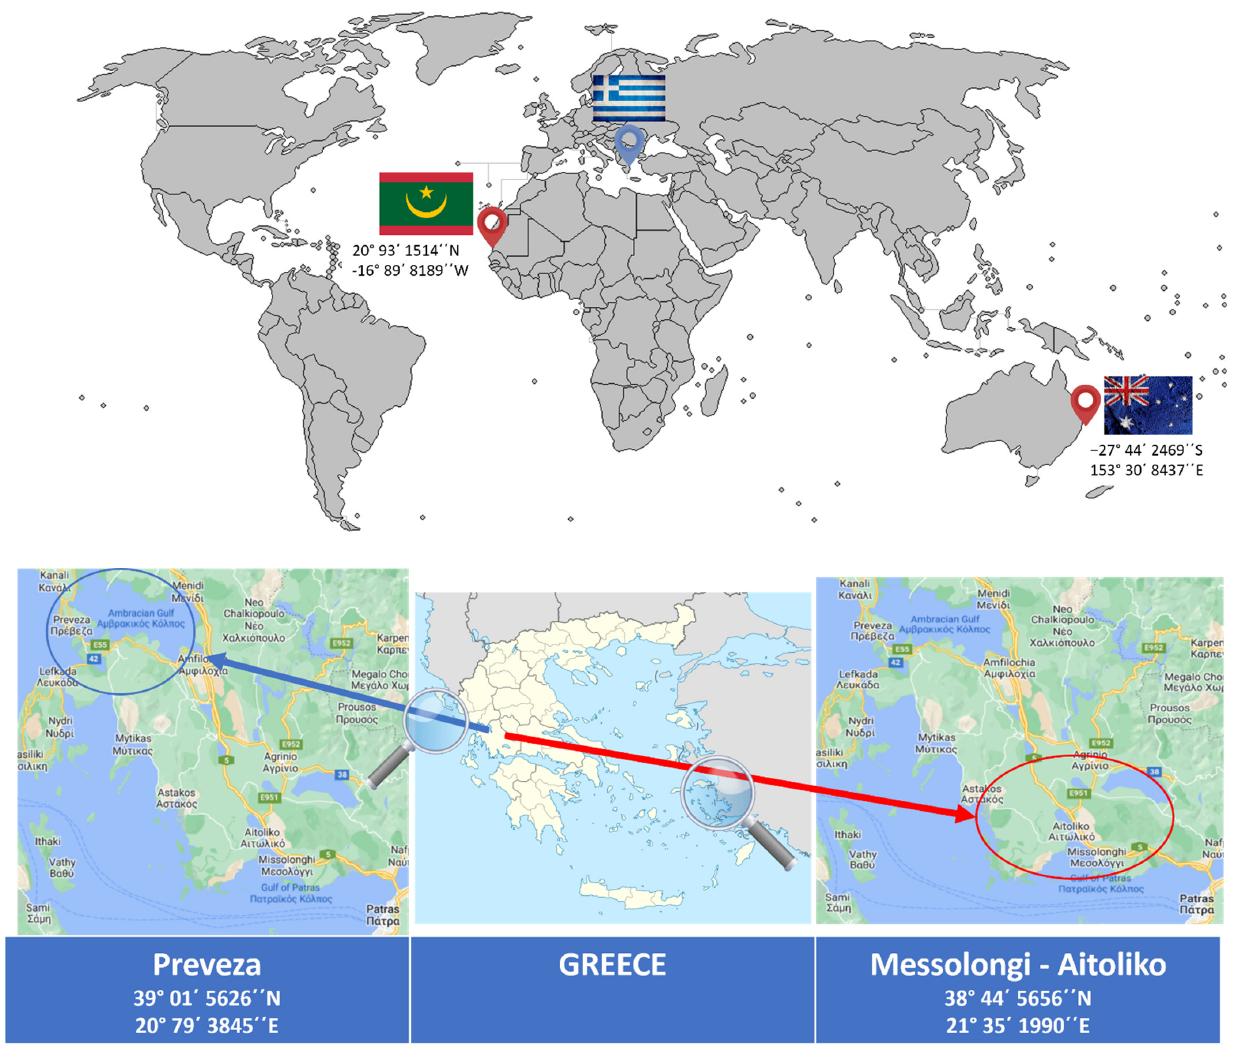
Figure 1. The areas producing the examined Bottarga products.